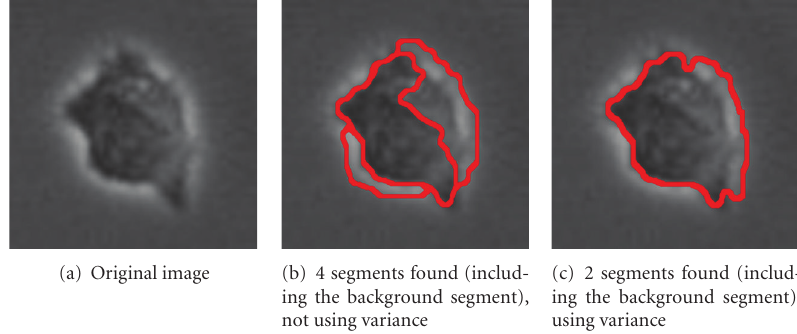
Figure 7: Parameters used: (b) n = 60, α = 100, (cid:7) α = 10, θ = 0 . 1, γ = 0 . 5, d 1 = 0 . 15, σ = 6; (c) n = 60, α = 100, (cid:7) α = 10, β = 30, θ = 0 . 1, γ = 0 . 5, d 1 = 0 . 15, σ = 6, ρ = 1.